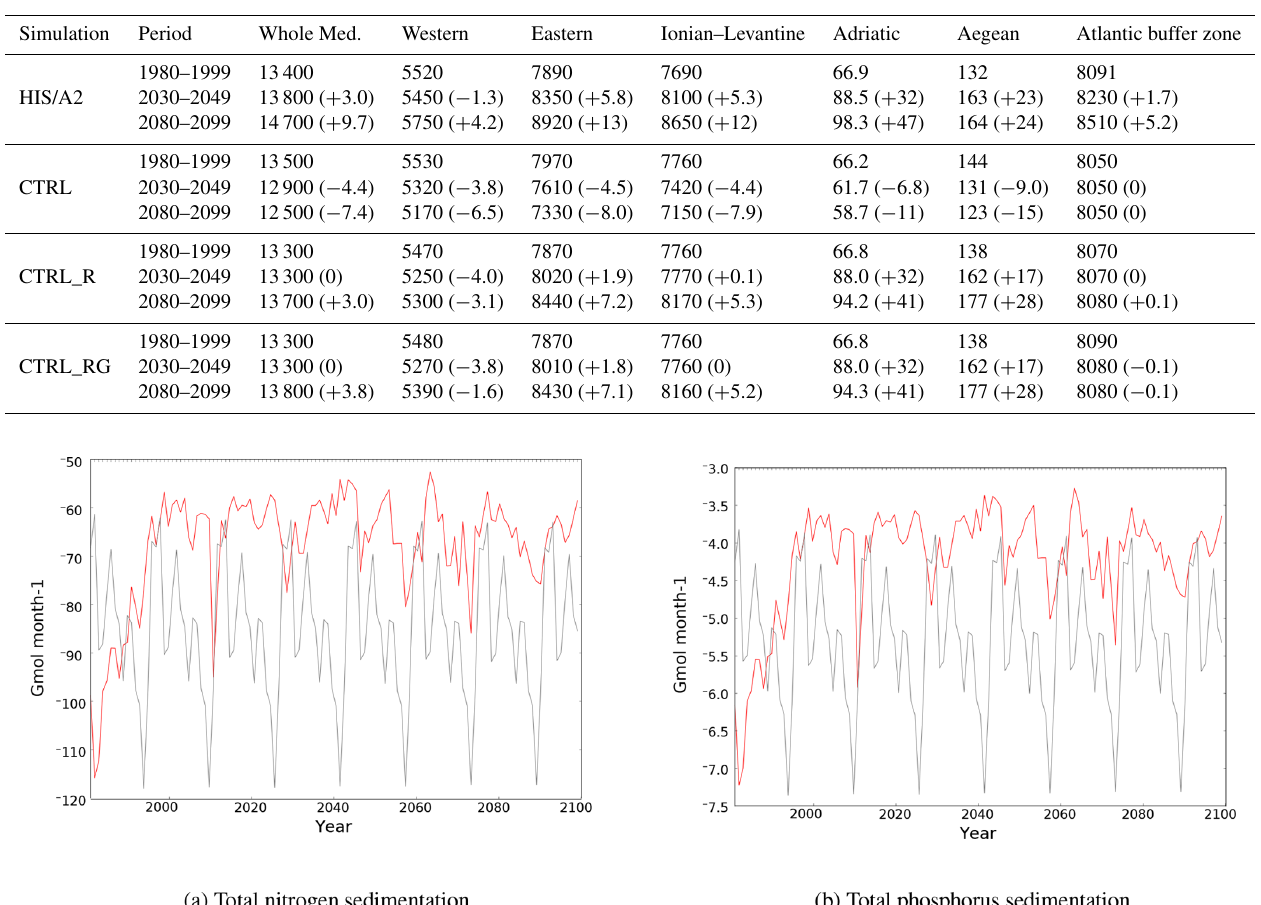
Table 3. Simulated integrated nitrate content (10 9 mol) over 20-year periods in the Mediterranean sub-basins in the different simulations. Basins are the same as defined in Fig. 2 of Adloff et al. (2015), with the eastern basin including the Ionian, Levantine, Adriatic, and Aegean sub-basins. Values in parenthesis indicate the percentage difference from the 1980–1999 period.